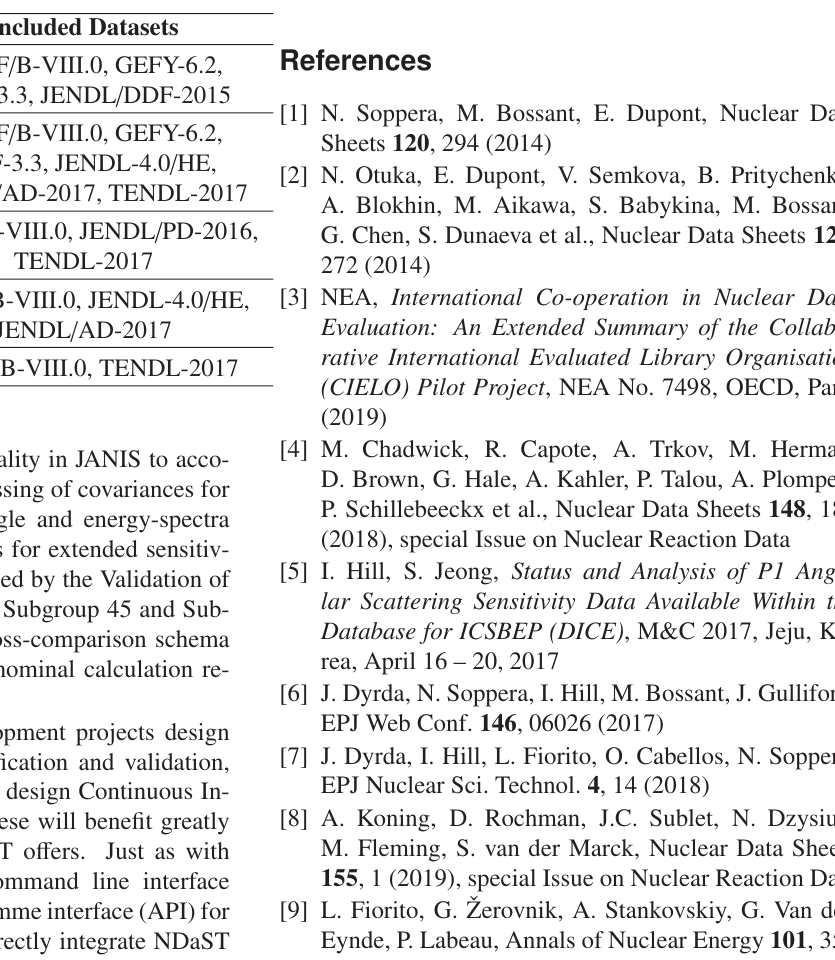
Table 2. Summary of the new nuclear data libraries added to JANIS since the ND2016